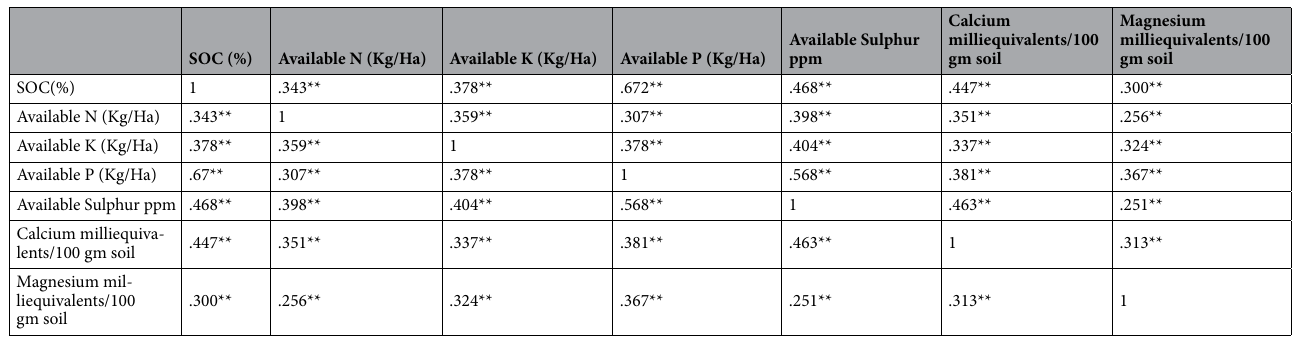
Table 3. Pearson’s correlation matrix (2-tail) for the SOC, major and minor nutrients. **Correlation is significant at the 0.01 level